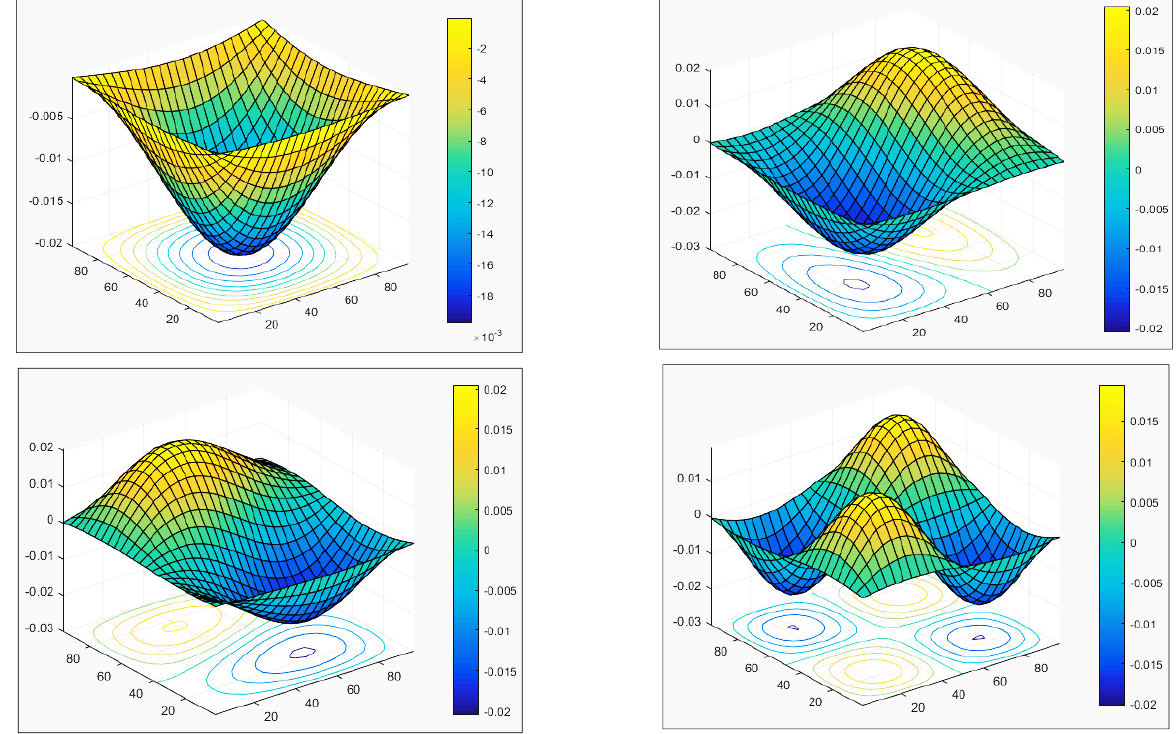
Fig. 2. Mode shape for free vibration of (SSSS) for [30 -30 30] laminated square plate a-first b-second c-third d- fourth modes.